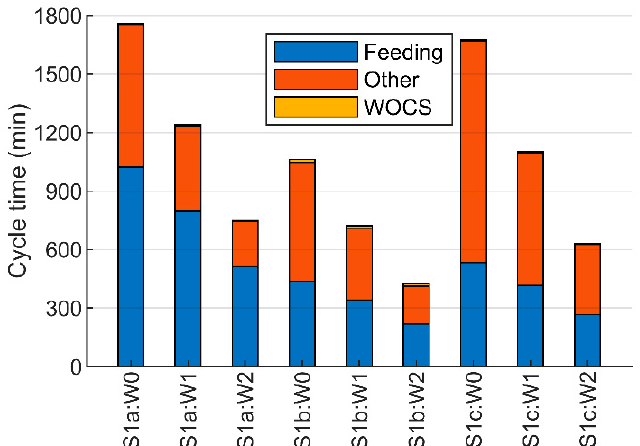
Figure 8. Estimated robot winding cycle time results for complete S1a–c stators in winding development scenarios W0–2, divided into feeding time, other time and WOCS time.